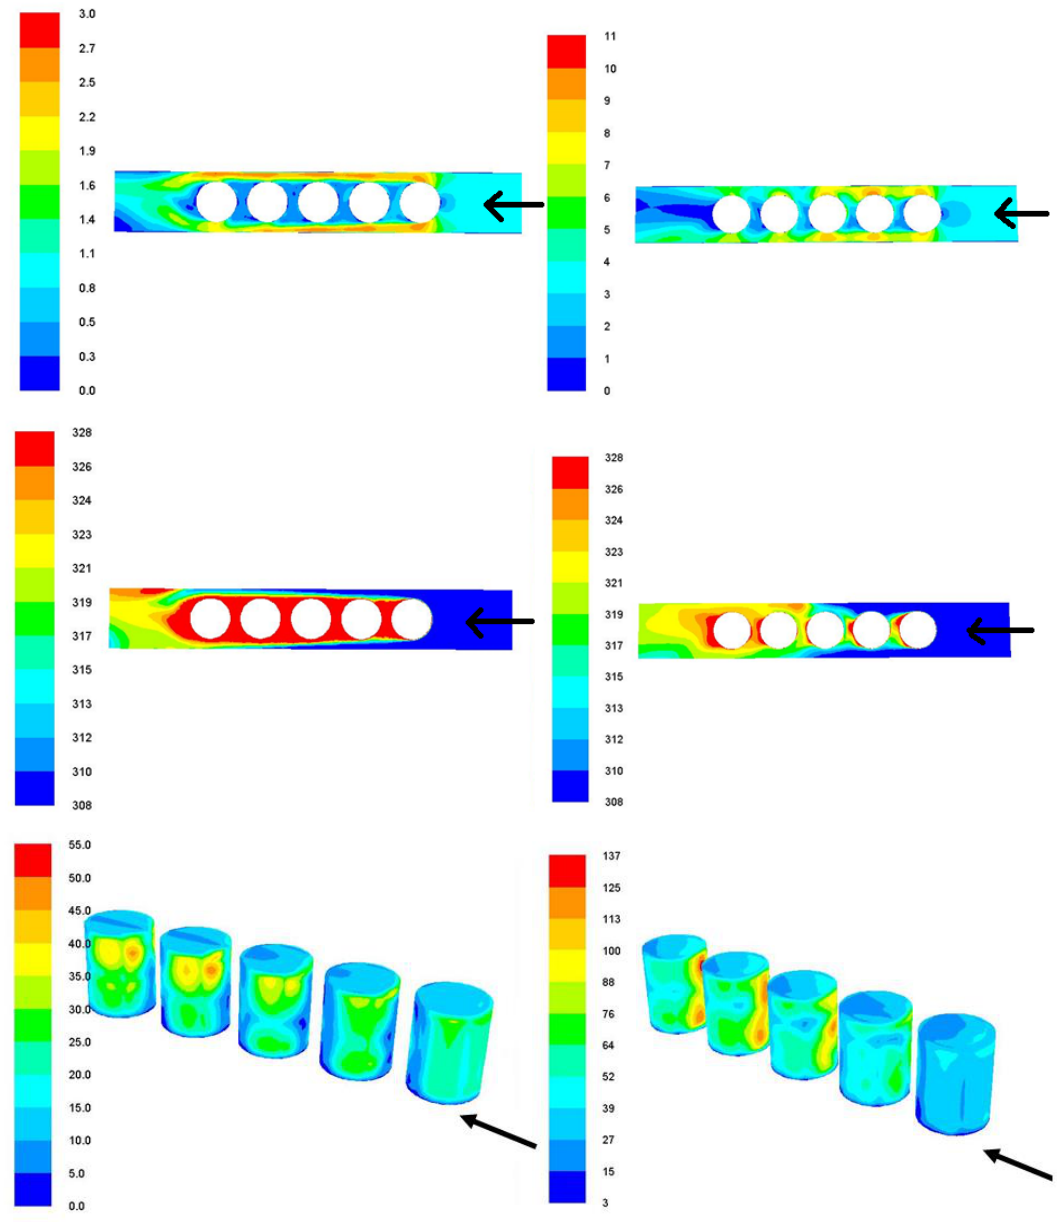
Figure 3. ( Top ) Flow velocity around the drums ( left : vin = 1 m/s, right : vin = 3 m/s). ( Middle ) Temperature field around the drums ( left : vin = 1 m/s, right : vin = 3 m/s). ( Bottom ) Heat transfer coefficient distribution over the drums ( left : vin = 1 m/s, right : vin = 3 m/s).